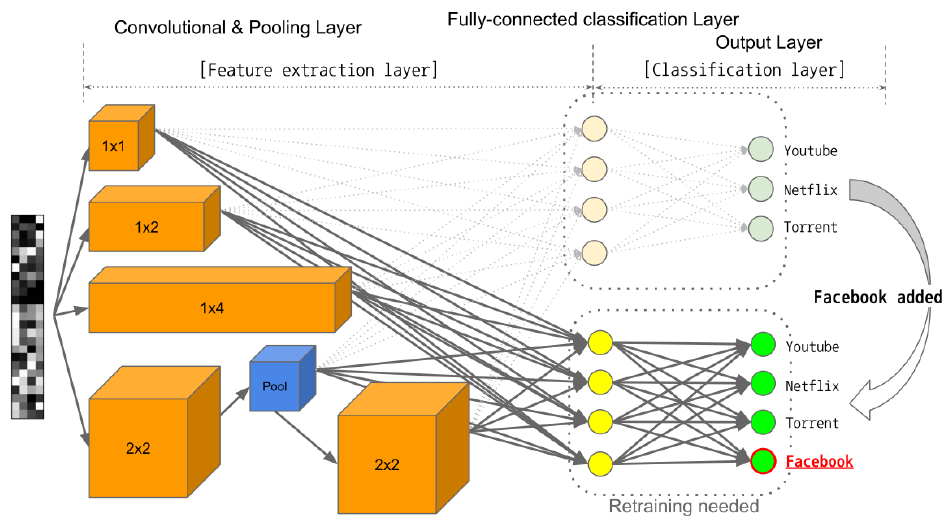
Figure 5. Model transformation when a new application is added (Facebook): FLIC keeps the weight of the feature extraction layer, but trains the classification layer weight for the new